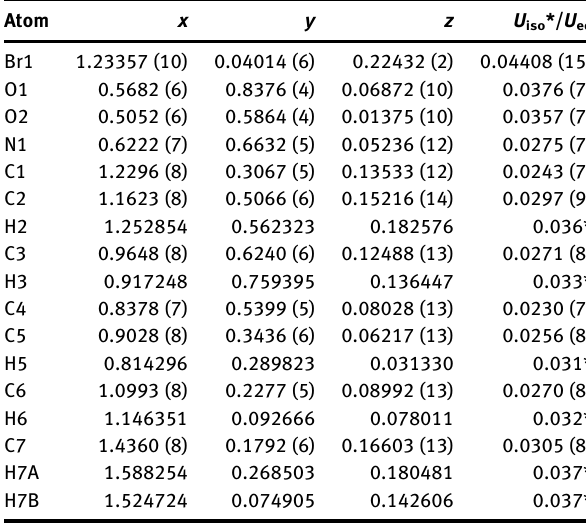
Table  : Fractional atomic coordinates and isotropic or equivalent isotropic displacement parameters (Å 